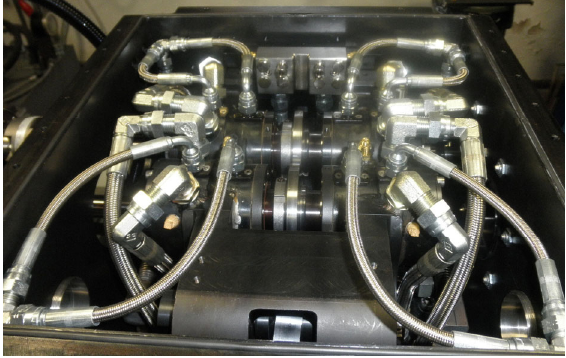
Fig. 11 Image of test box of twin disc machine.